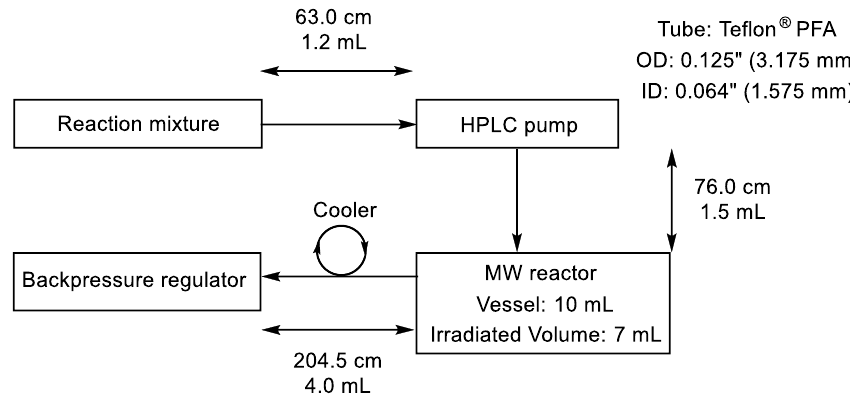
Figure 6. Design parameters of the continuous flow system.